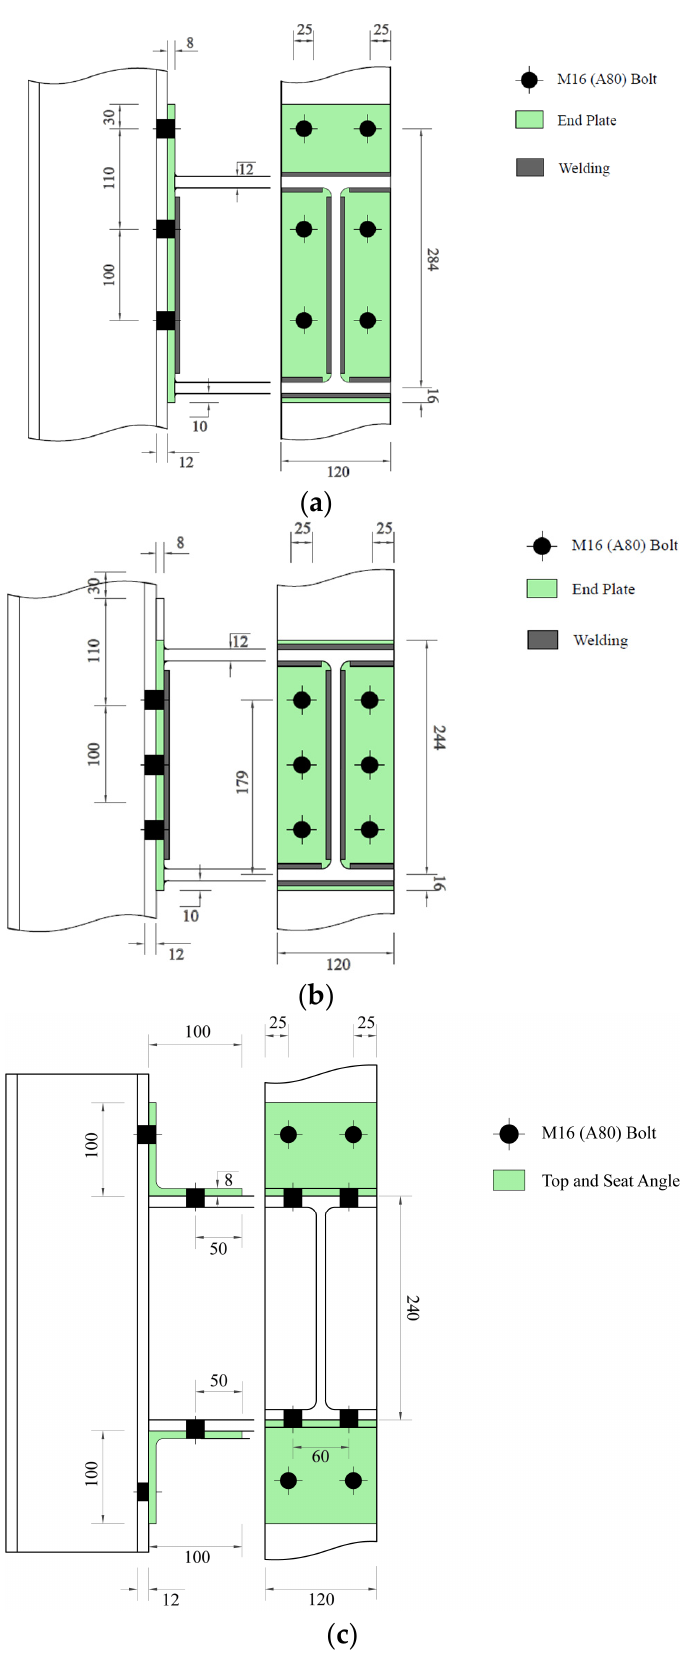
Figure 5. Geometrical properties of investigated joints. ( a ) Extended End-Plate (EEP); ( b ) Flush End Plate (FEP); ( c ) Top-and-Seat Angle Cleat